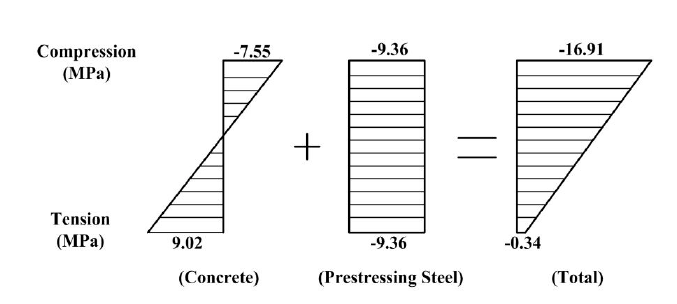
Table 7. Prestressing force. Figure 14. Total stresses on